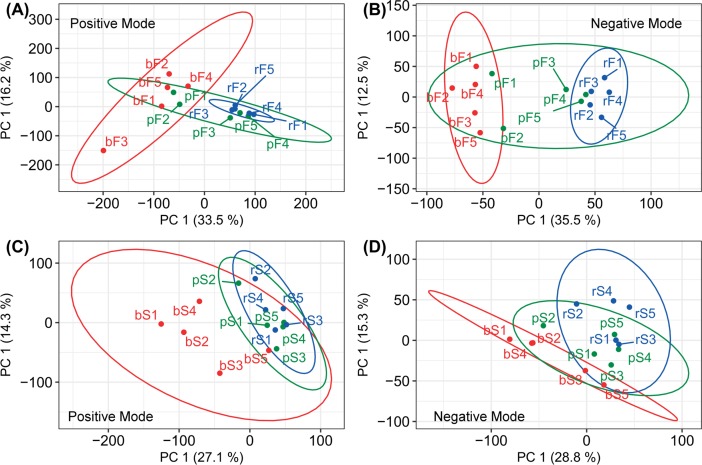
Score plots for the principal component analysis.(A) and (B), the score plots based on the first two components derived from the PCA analysis of the leaf tissues analyzed in positive and negative ion modes, respectively. (C) and (D), the score plots based on the first two components derived from the PCA analysis of the sheath tissues analyzed in positive and negative ion modes, respectively. In the PCA results (A), (B), (C) and (D), the first two components explained 49.7%, 48.0%, 41.4% and 44.1% of the total variances, respectively. Samples bF 1–5, pF 1–5 and rF 1–5 were collected from the control, the phenylacetic acid and R. solani treated leaf tissues, respectively. Samples bS 1–5, pS 1–5 and rS 1–5 were collected from the control, phenylacetic acid and R. solani treated sheath tissues, respectively.